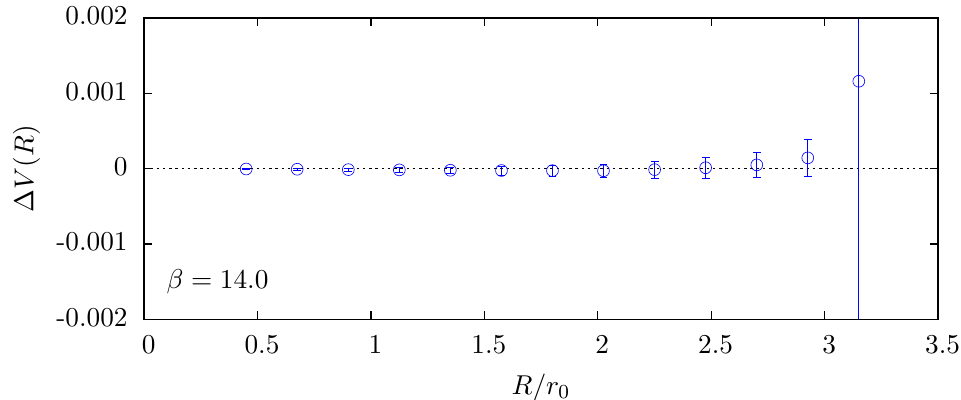
Figure 9 . Di(cid:11)erence in the results for the static potential (cid:1) V from temporal extents 48 and 64 at (cid:12) = 14 : 0 versus the q (cid:22) q -separation in units of r 0 . As can be seen from the plot, the two sets of energies agree perfectly within errors for the whole range of q (cid:22) q separations considered, meaning that excited states are negligible. Since for the di(cid:11)erent ensembles T changes only little in physical units, we expect this to hold for all lattices considered. Note, that the energy levels (and the overlaps) of the (cid:13)ux